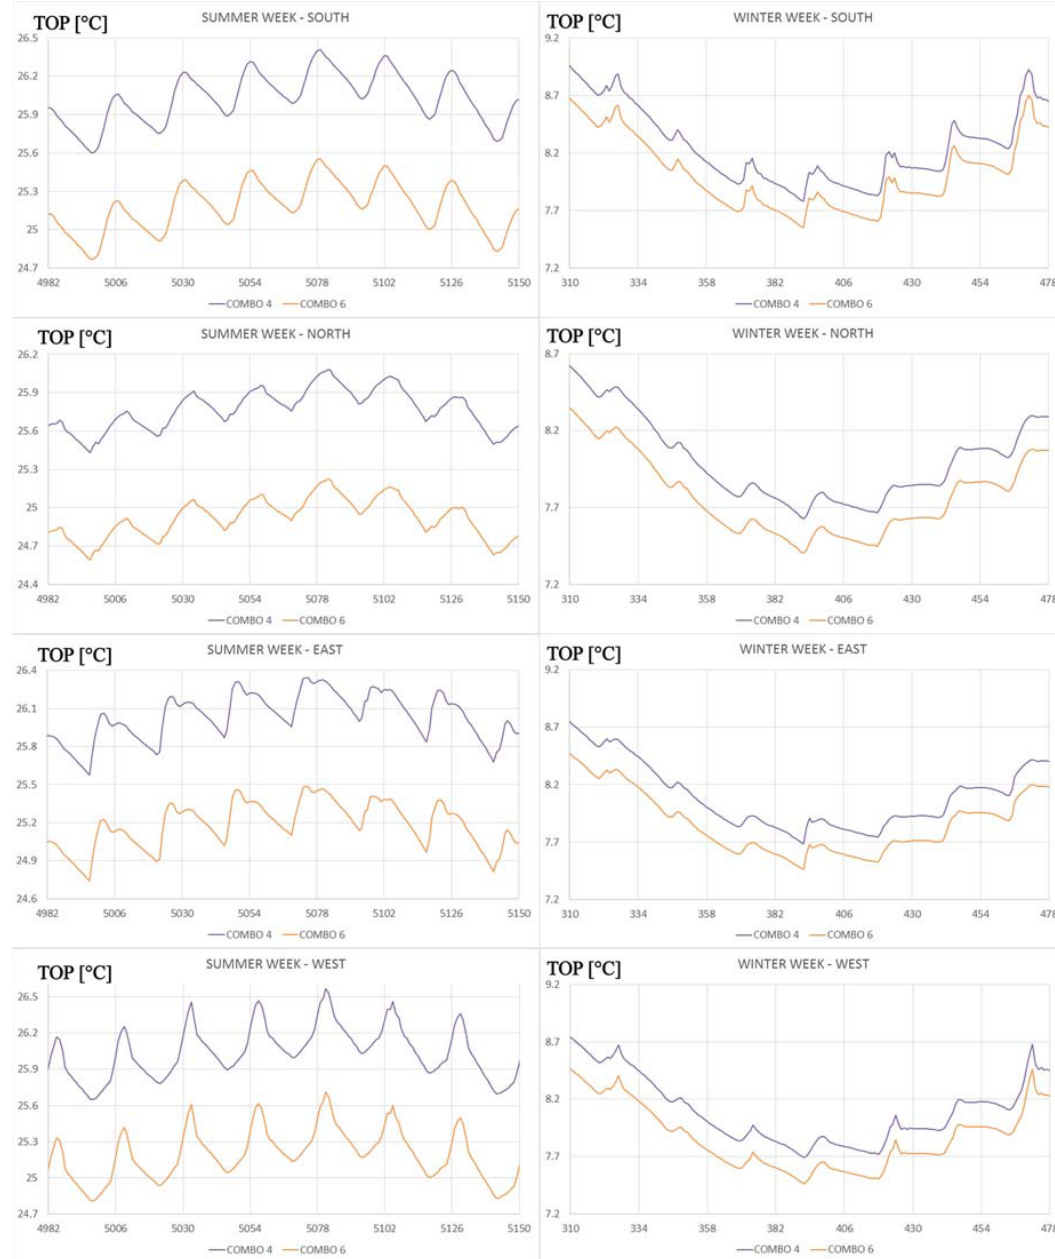
Figure 5. TOP graphical trend for the STEP 2 (27 July–2 August; 12 January–18 January).